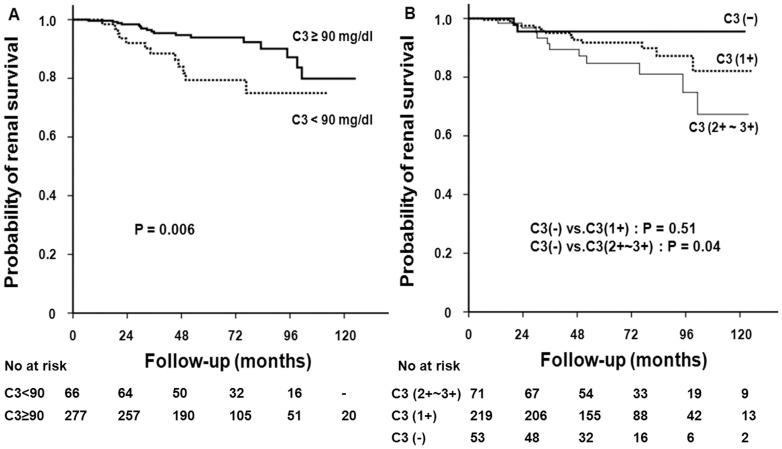
Kaplan-Meier analyses of cumulative renal survival of patients with IgA nephropathy based on (A) serum C3 level and (B) mesangial C3 deposition.(A) A 10-year renal survival rate was significantly lower in patients with C3 levels <90 mg/dl than those with C3 levels ≥90 mg/dl (P = 0.006). (B) A 10-year survival in patients with 2+ and 3+ mesangial deposition of C3 was lower than in those without C3 deposition (P = 0.04).